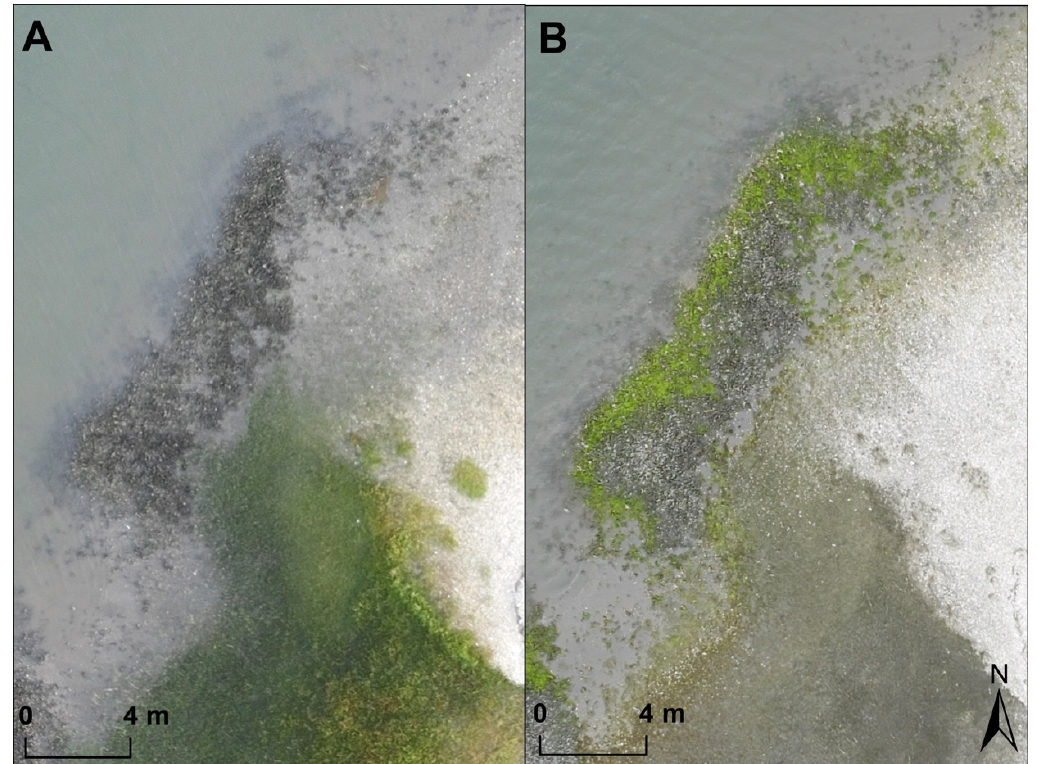
Figure 7. Comparison of an individual fringing oyster reef on Town Marsh, Rachel Carson Reserve, NCNERR between A) Fall 2017 and B) Spring 2018 collected from fixed-wing eBee UAS. Reef area delineation could be impacted by algal growth and inundation